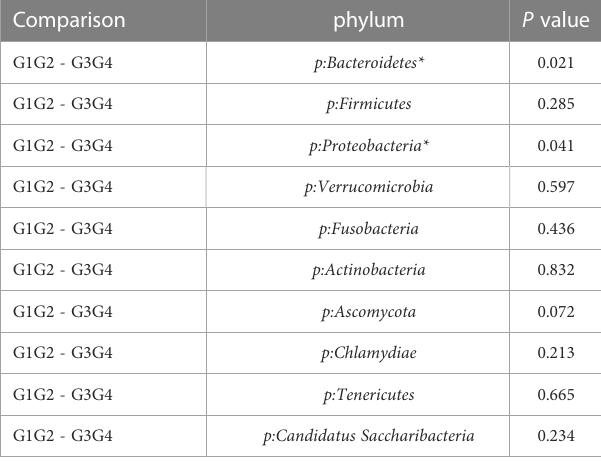
TABLE 3 Adonis test for differences between groups. groups